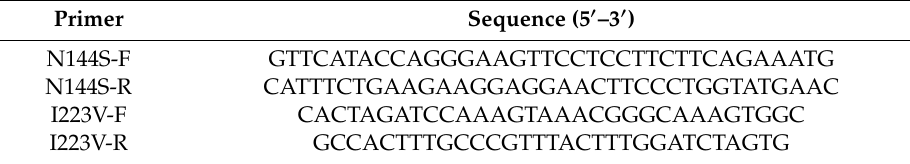
Table 1. Primers used in this study for site-directed mutagenesis.